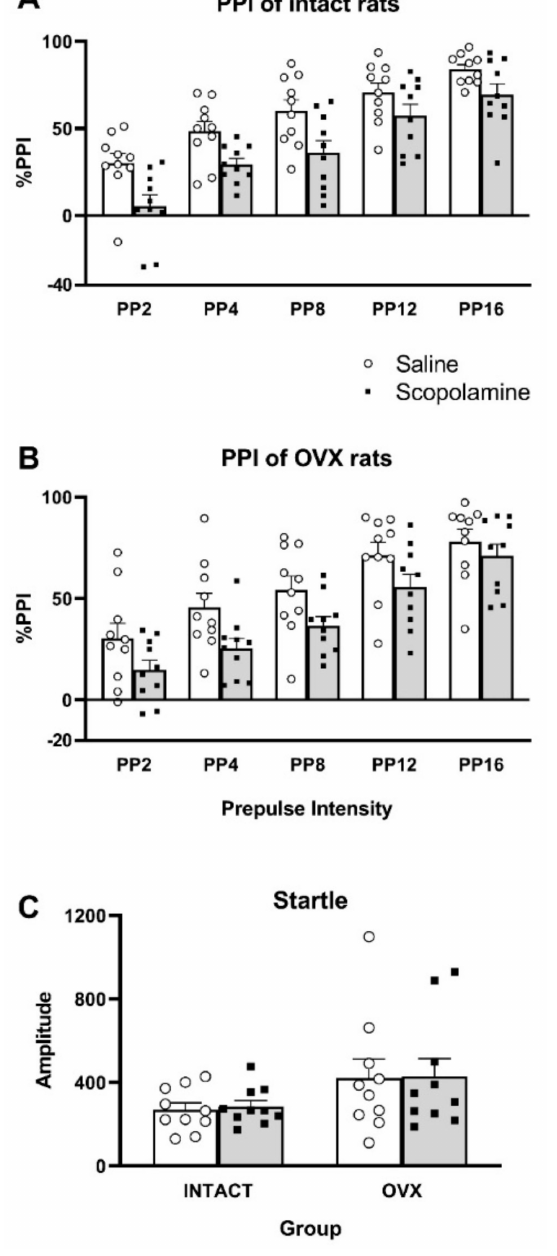
Figure 3. Prepulse inhibition (PPI; graphs A and B ) and startle responses (graph C ) in intact or ovariectomized (OVX) rats ( n = 10 per group). Rats were tested after treatment with saline (white bars) or 0.3 mg / kg scopolamine (grey bars). Individual data are depicted by open circles (saline) or black squares (scopolamine). %PPI refers to the di ff erence in startle between the pulse-alone trials and the prepulse-pulse trials, divided by the response to the pulse-alone trial × 100%. Prepulse intensity (PP) refers to the trials that were 2, 4, 8, 12, or 16 dB above the 70 dB background noise followed 100 ms later by the 115 dB startling pulse. Startle amplitude refers to the average of the four blocks of eight 115 dB startling pulses. Bars represent mean ±